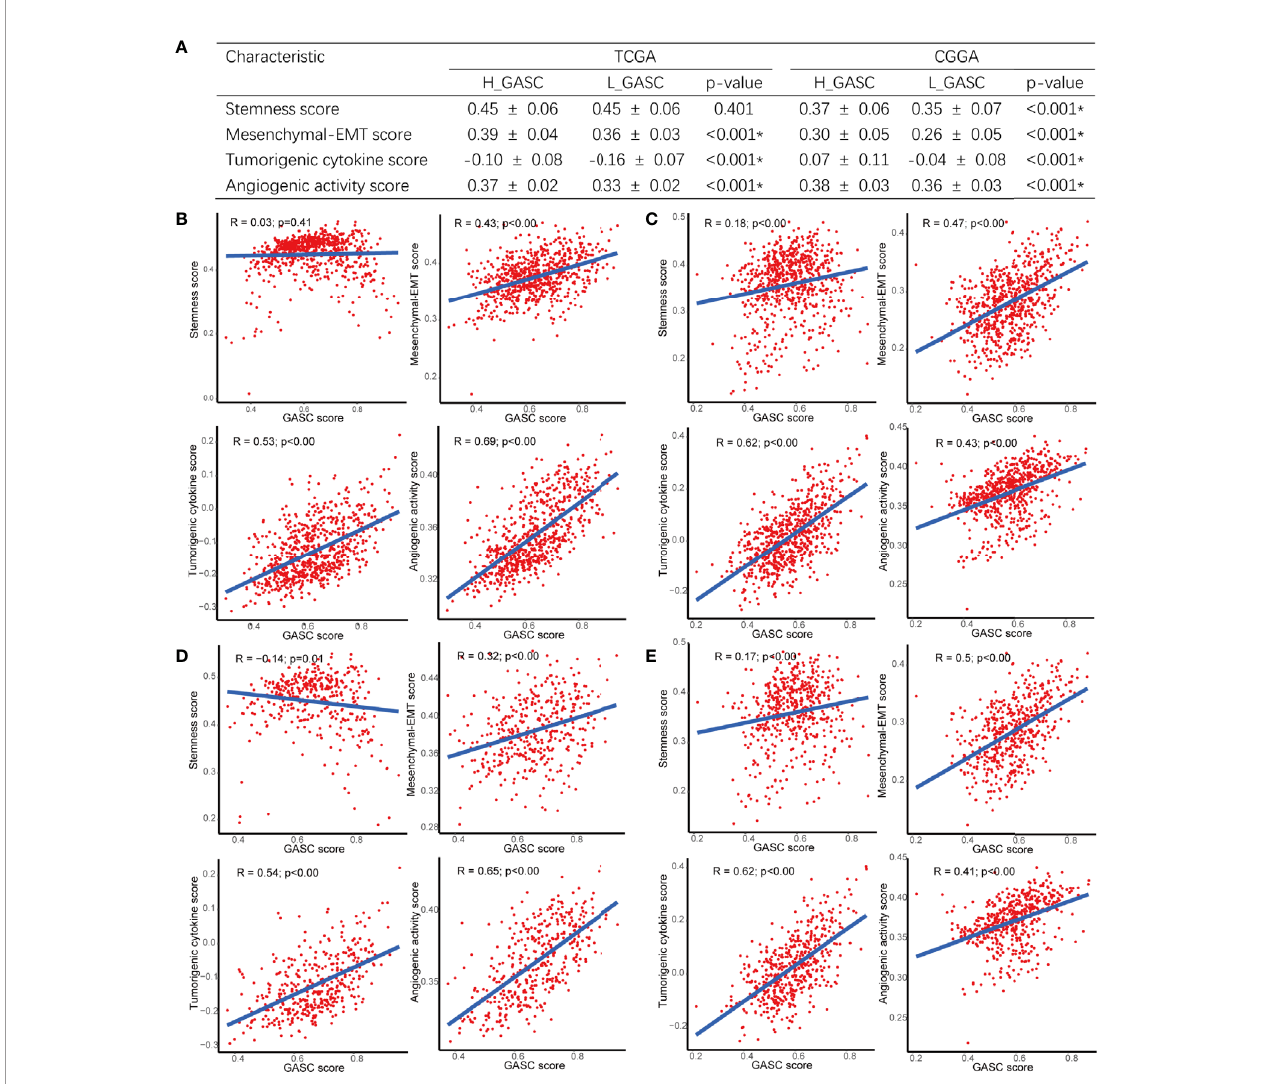
FIGURE 5 | Correlations between GASCs and Stemness, Mesenchymal-EMT, Tumorigenic cytokine, and Angiogenic activity scores. (A) Correlations between GASC groups and stemness, mesenchymal-EMT, tumorigenic cytokine and angiogenic activity scores. (B – E) Scatterplot of GASC score and 4 scores in all glioma population ( B for TCGA and C for CGGA) and high-grade glioma population ( D for TCGA and E for CGGA). *Statistical signi fi